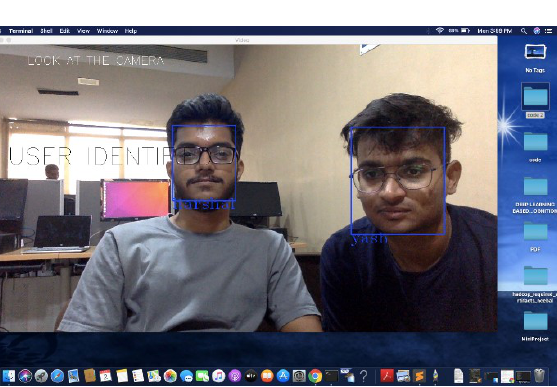
Fig 8: Surveillance system detecting multiple